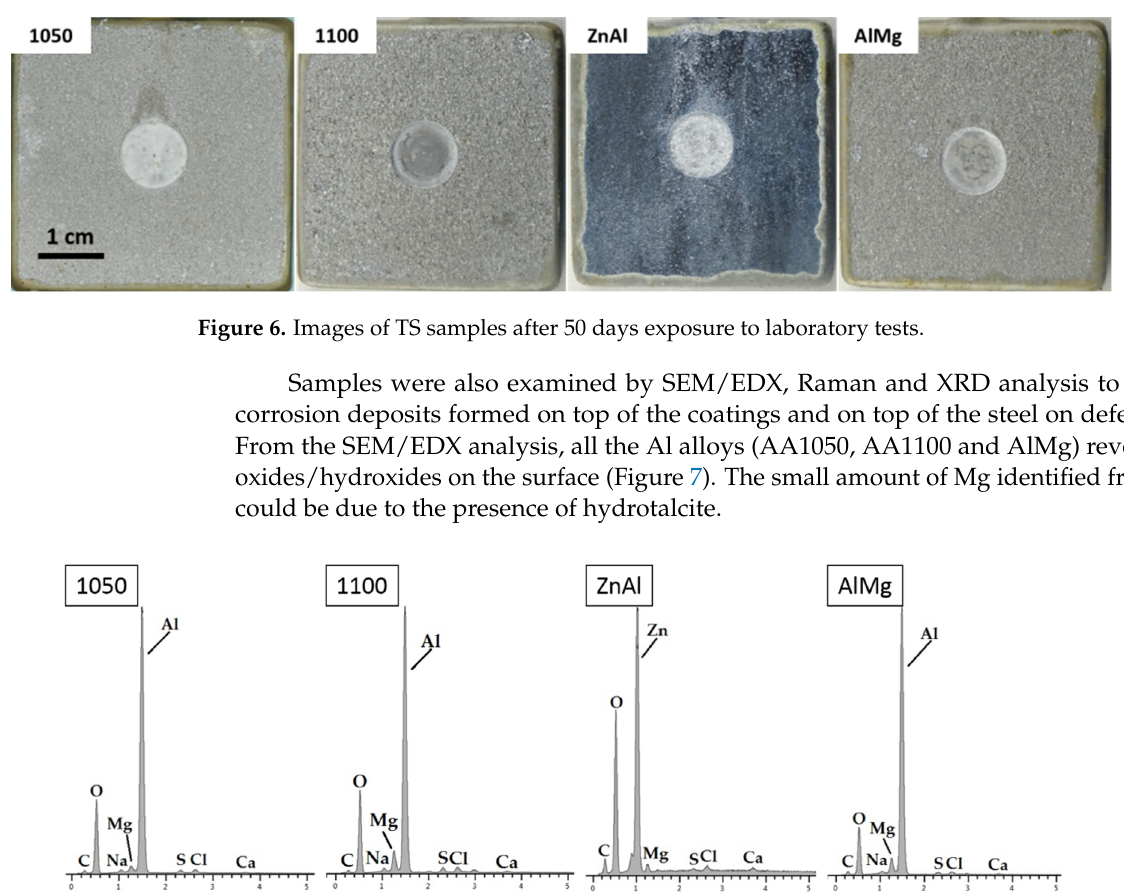
Figure 7. EDX (energy dispersive X-ray spectroscopy) results obtained from top view analysis of TS coatings after 50 days of exposure to artificial seawater in controlled laboratory conditions.